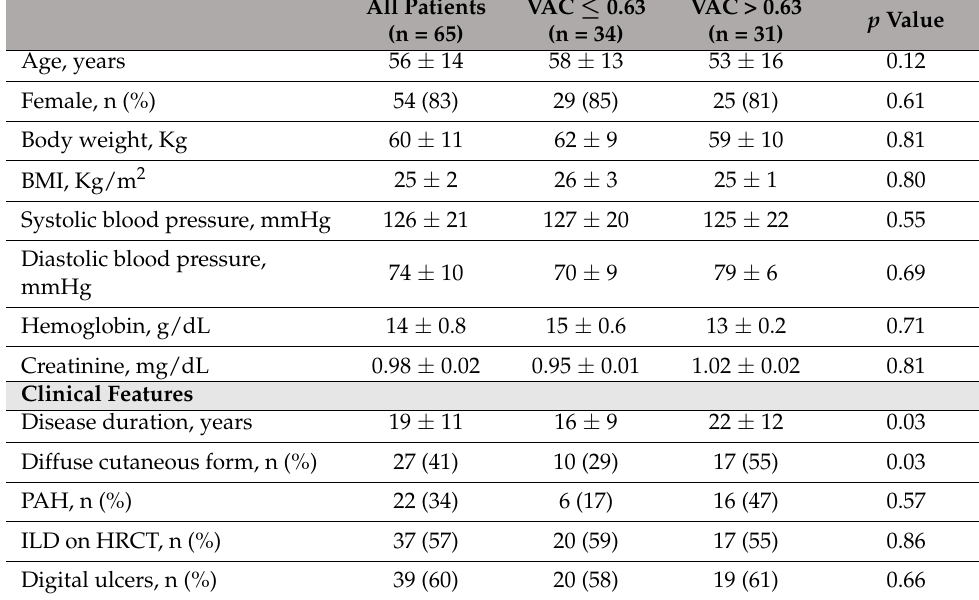
Table 1. Clinical and Echocardiographic Features in SSc Patients with and without VAC >